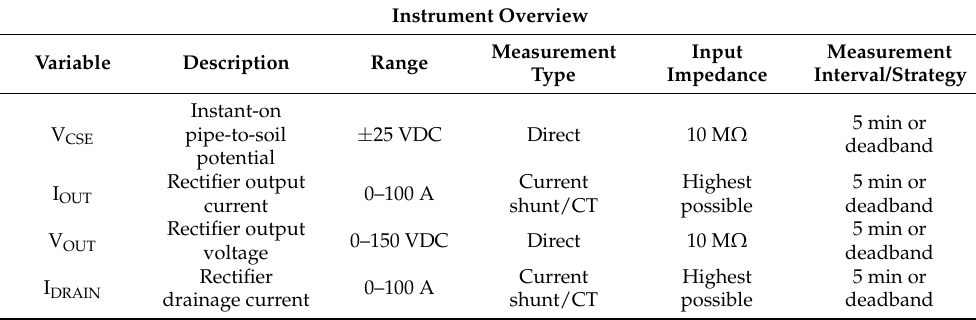
Table 1 is a summary of the measurement strategy used for this paper: Table 1. Instrument